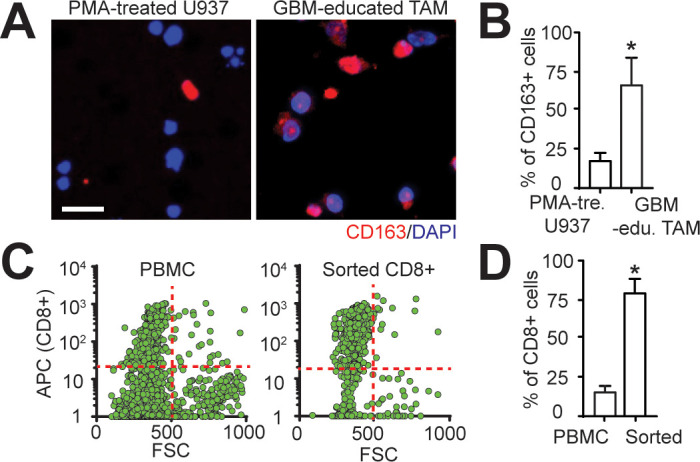
Sample preparation for TAMs and effector CD8+ T-cells.(A) Representative immunofluorescence images showing CD163 expressions on PMA-treated U937 monocytes with and without treatments of GBML91’s conditioned-media. Scale bar is 50 µm. (B) Quantified results showing more CD163+ macrophages in GBML91-educated U937 cells. (C) Quantified flow results showing the purity of sorted CD8+ T-cells from PBMCs. APC represented the fluorescent intensity of CD8+ markers. (D) Quantified results showing the purity of sorted CD8+ T-cells is ~80%. p-Values were calculated using the unpaired two-tailed Student’s t-test. *, p<0.05.